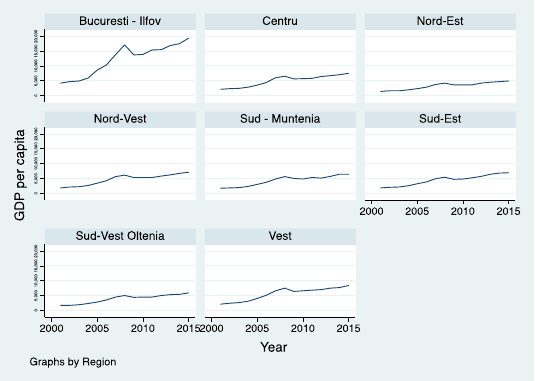
Figure 6. Dynamic of GDP per capita in Romanian regions. Source: computed by the authors based on the Eurostat database [23] using Stata 15.1.